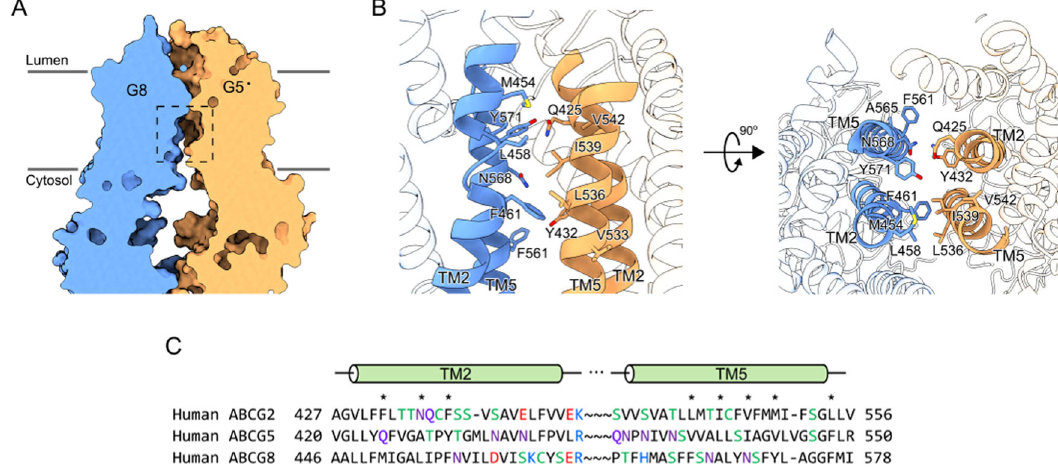
Fig. 4 Putative cholesterol-binding pockets in ABCG5/G8. A Cross-section of the transmembrane region of ABCG5/G8 shows a putative cholesterol- binding pocket (rectangle in dashed line). B Zoom-in view of the putative cholesterol-binding site shows that it is constructed by TM2 and TM5 of ABCG5 and ABCG8. Amino acid residues likely important for cholesterol binding are shown as sticks. C Sequence alignments of TM2 and TM5 between ABCG2, ABCG5, and ABCG8. Amino acid residues likely important for cholesterol binding are marked by an